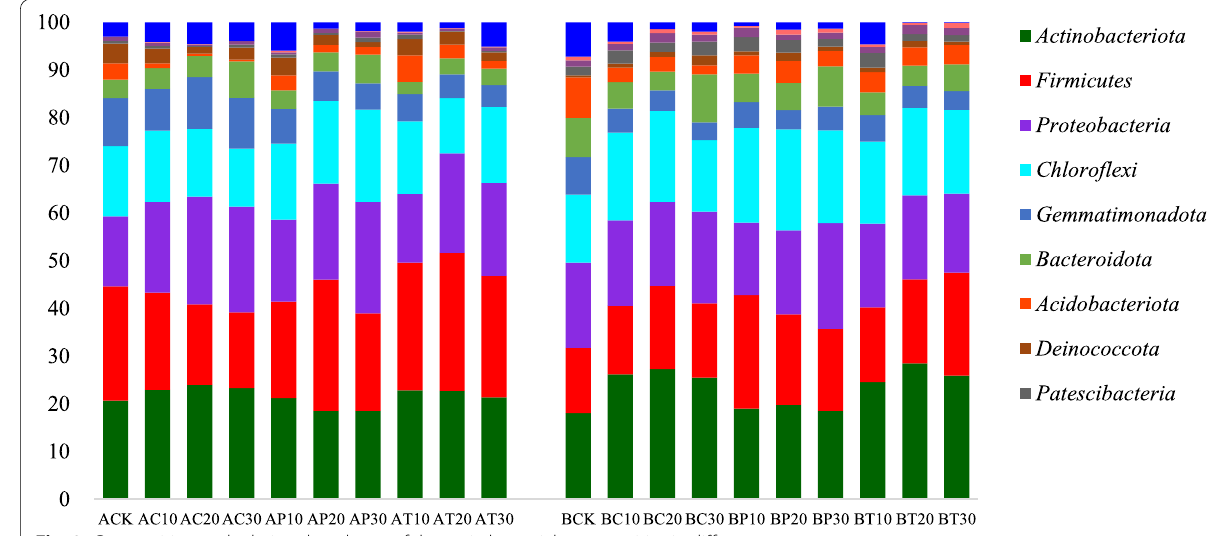
Fig. 3 Composition and relative abundance of the main bacterial communities in different treatments